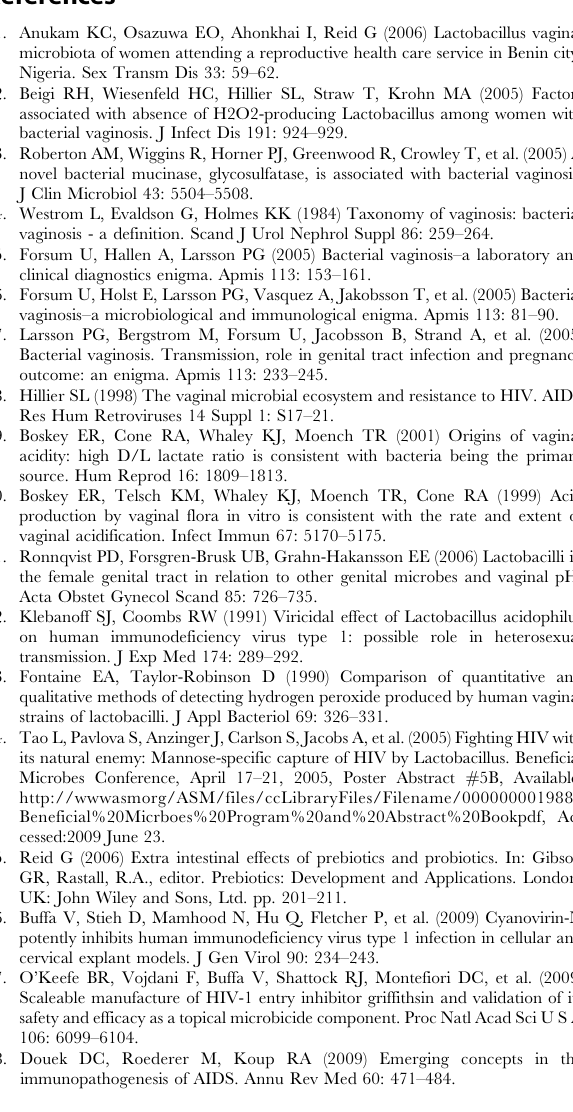
Table S1 Complete list and phylogenetic/phenotypic details of isolates. Table S2 Characteristics of individuals providing vag- inal samples in Winnipeg (N=